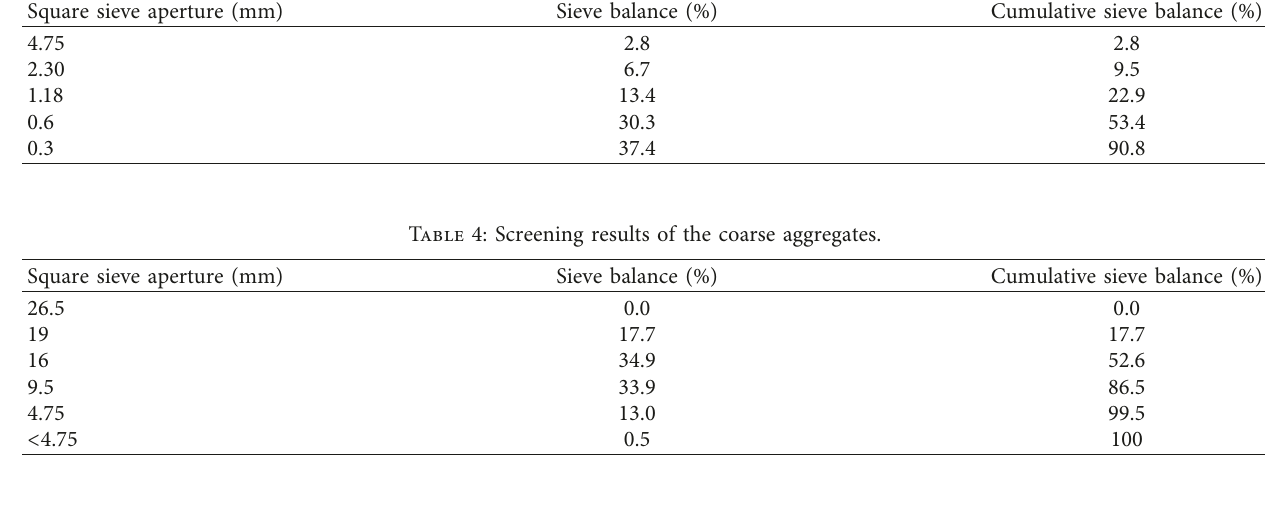
Table 5: Technical indicators of the rubber powder.